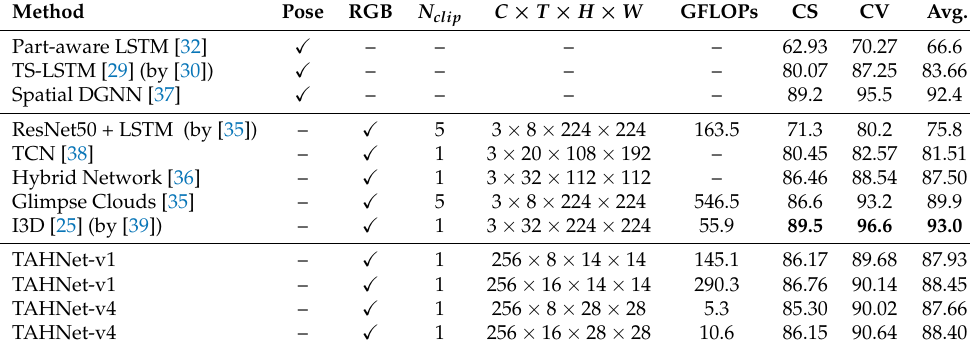
Table 1. Comparison results with the SOTA methods on the NTU RGB + D dataset. N Clip is the number of clips used for testing, respectively. C , T , H and W mean the input channel, time, height and width dimensions of the temporal action head network, respectively. GFLOPs is giga floating point operations. Pose RGB N